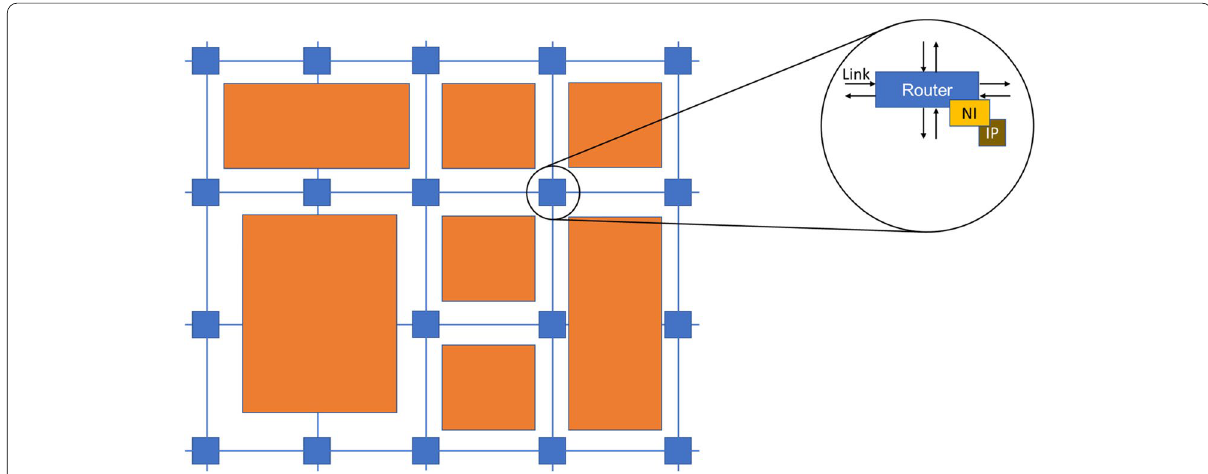
Fig. 2 Network on Chip Segmentation for